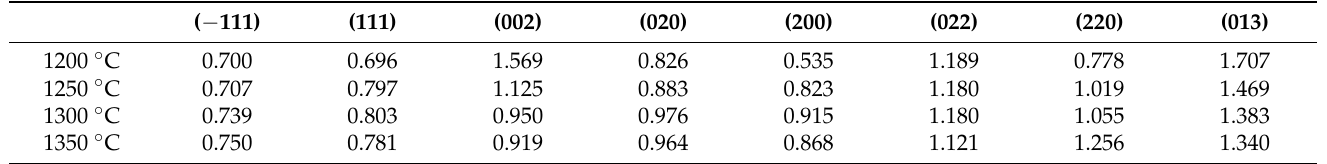
Table 2. The relationship between the texture coefficient and deposition temperature.